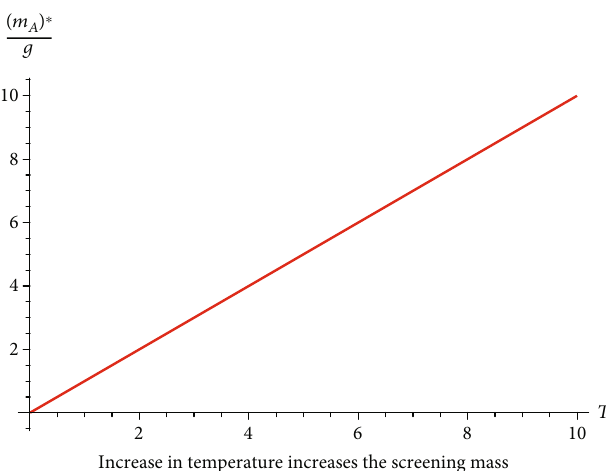
ð T Þ / σ 0 , in the UV regime against T / T s